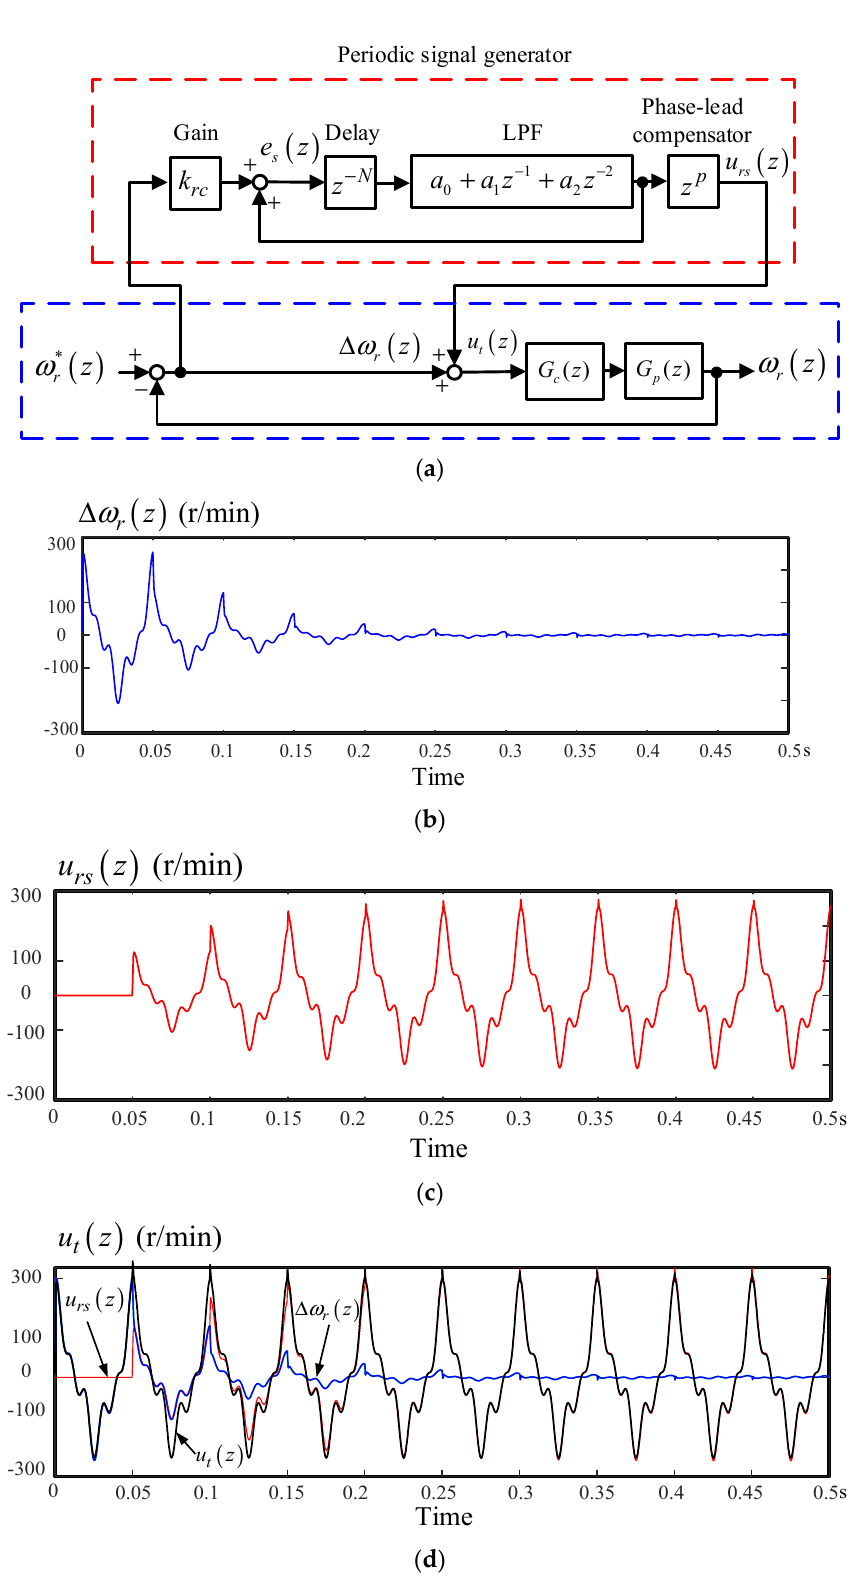
Figure 5. The periodic control: ( a ) block diagram; ( b ) speed error ∆ ω r ( z ) ; ( c ) periodic input u rc ( z ) ; ( d ) total control input.